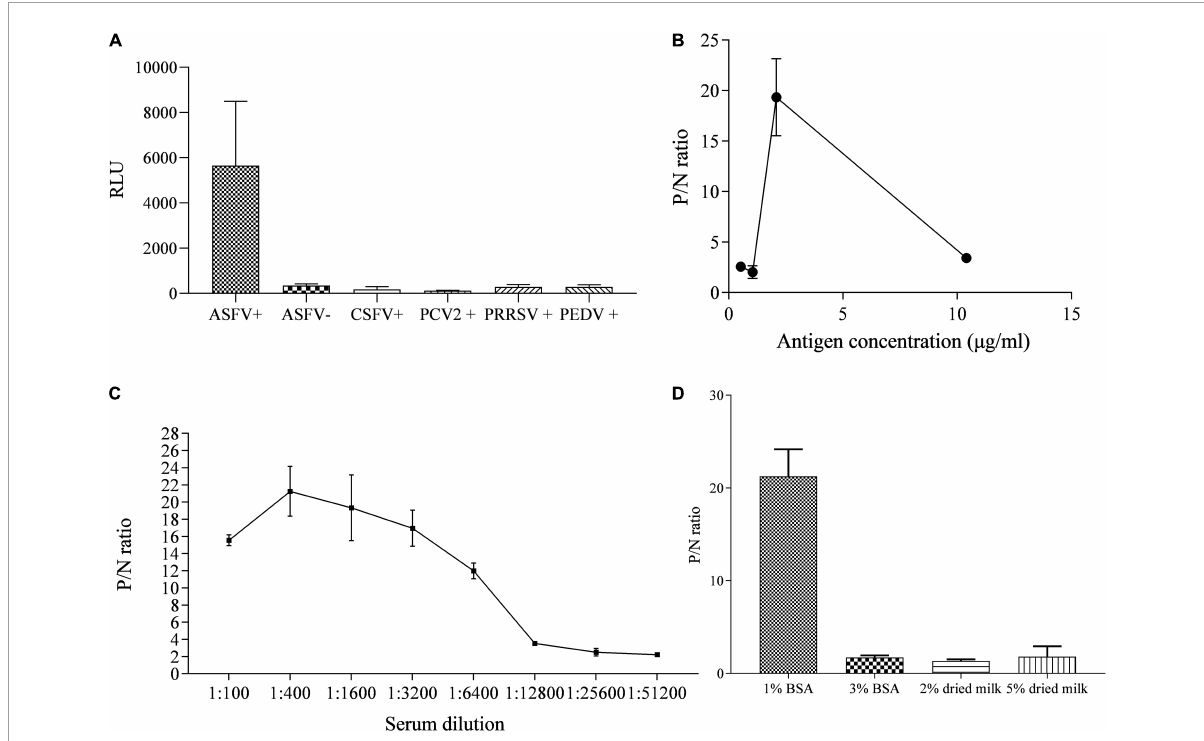
FIGURE3 The reactive specificity and optimization of the p35-Luc LISA in detecting ASFV-positive sera. (A) The reactive specificity of p35-Luc protein with the ASFV-positive sera was verified via an improved Luciferase immunosorbent assay (LISA), the sera raised against four swine pathogens including PCV2, CSFV, PEDV, and PRRSV were used as control serum. P/N values of testing serum samples corresponding to the concentrations of the 293T cell lysates containing the p35-Luc protein (B) , the dilution folds of testing serum (C) , the blocking buffer (D) . Data are shown with means ± SD. Error bars represent the standard deviations from triplicates.